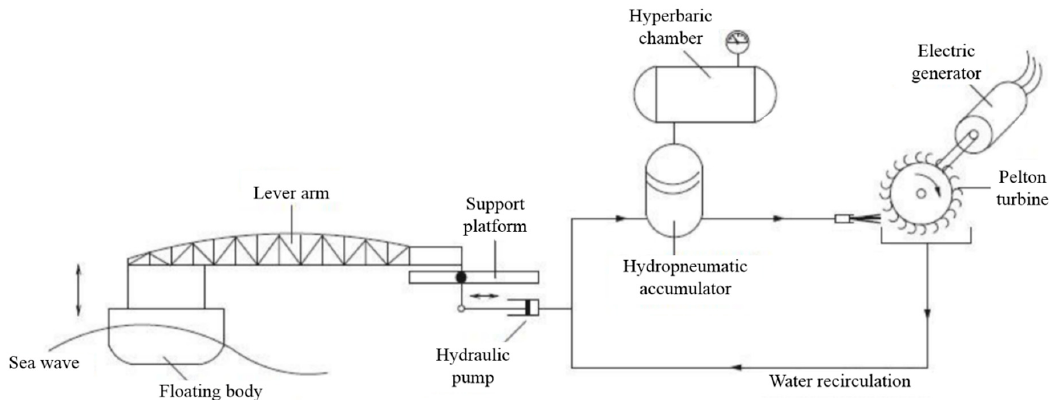
Figure 18. A schematic of the COPPE / UFRJ (Federal University of Rio de Janeiro) hyperbaric wave converter [185].